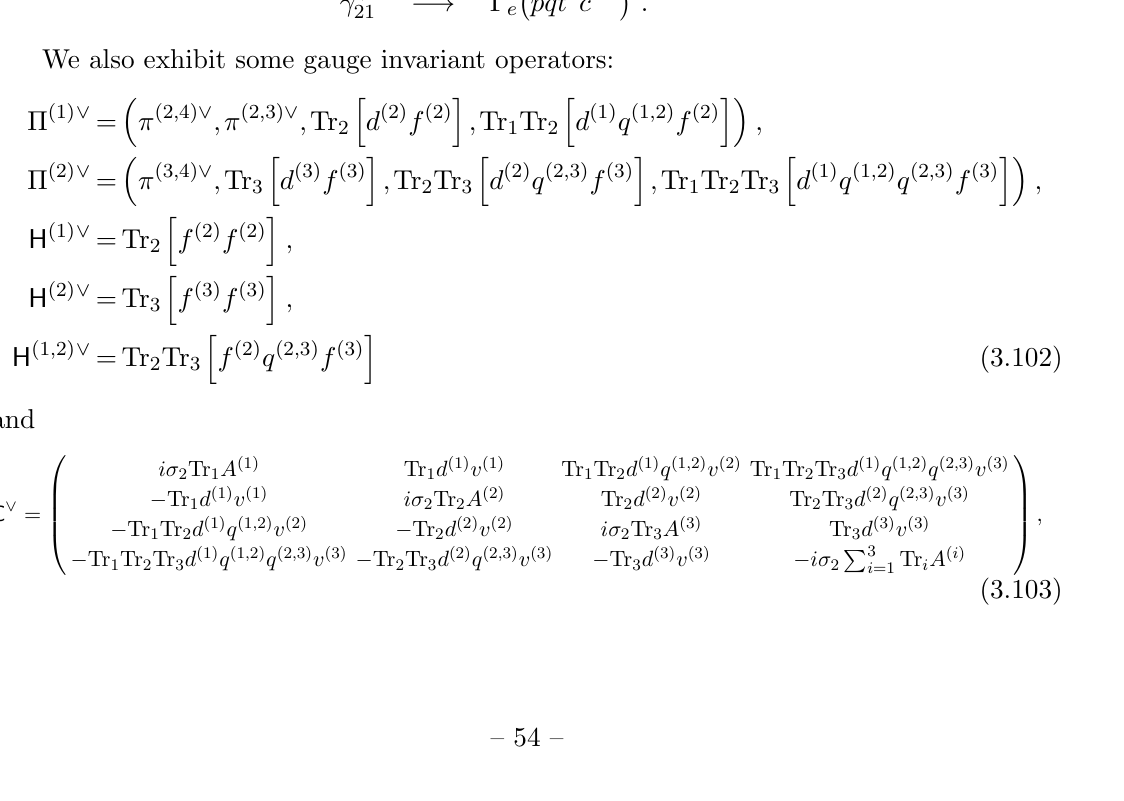
Figure 24 . The quiver diagram representation of E [2 ; 1 2 ] [USp(8)]. Two (cid:13)ipping (cid:12)elds (cid:13) _ denoted by crosses, (cid:13)ip Tr 1